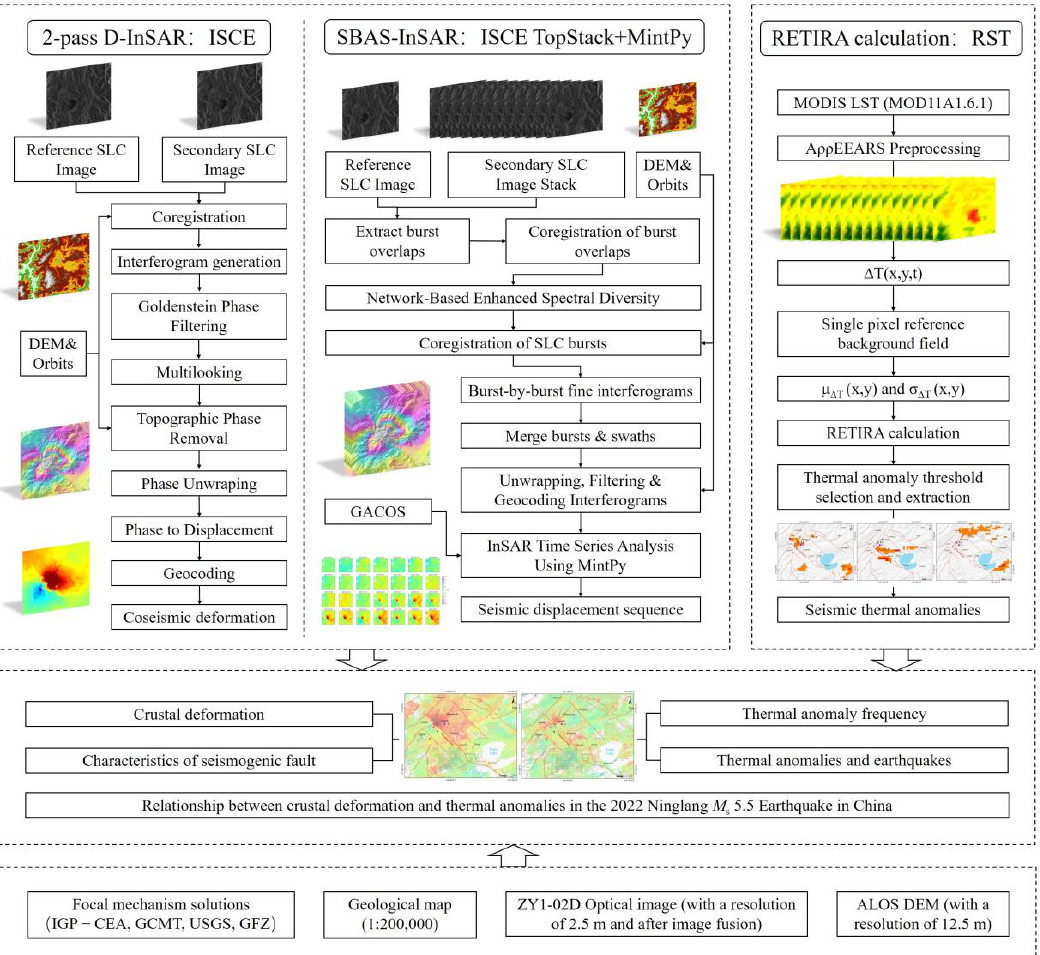
Figure 3. The general research framework.